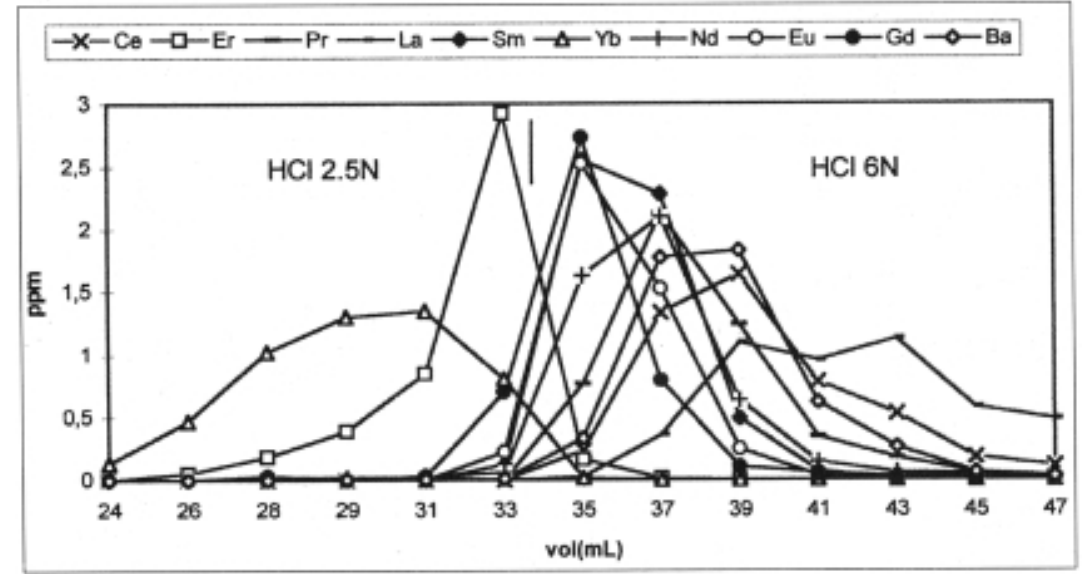
Fig. 1 – Separation of the REE group from the main elements of the